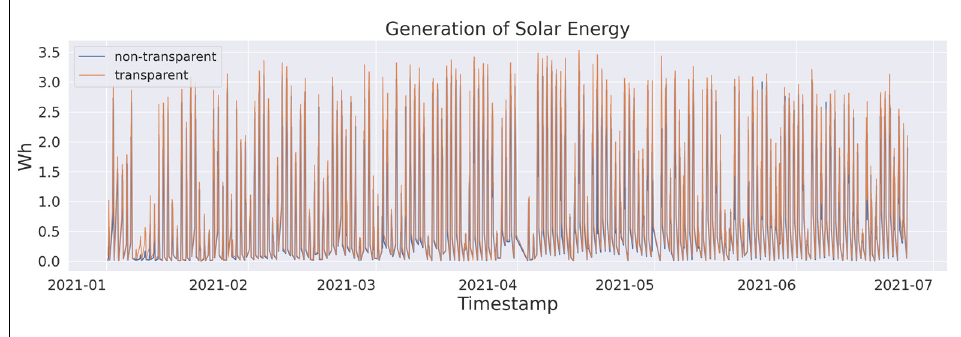
Figure 2. Generation of Solar Energy on hourly basis from both non-transparent and transparent type solar modules.